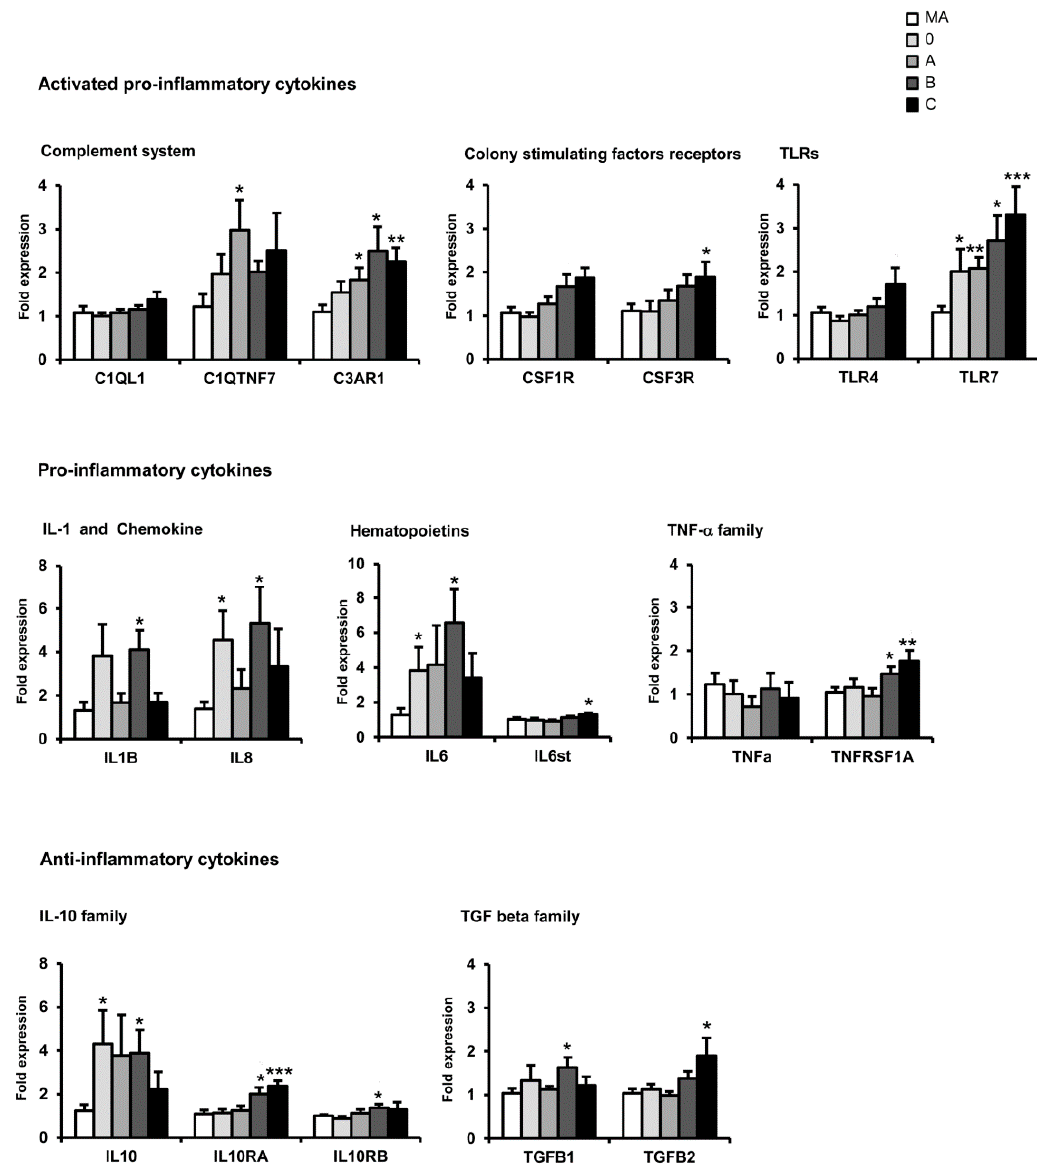
Figure 2. mRNA expression of selected cytokines and mediators of the immune response in the orbitofrontal cortex in AD cases at stages 0, A, B, and C according to the CERAD semi-quantitative assessment of neuritic plaques. Data are represented as the mean ± SEM * p < 0.05, ** p < 001, *** p < 0.001 (see Ref. [177] for details).